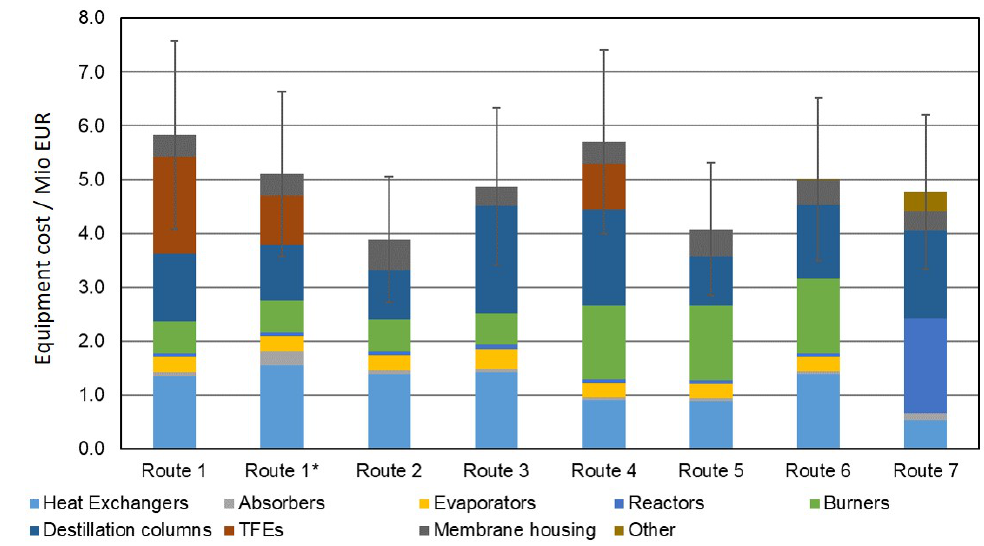
Figure 3. Equipment cost of all Routes for a plant size of 100 kt OME/a. The whiskers show the uncertainty in the total equipment cost for each route ( ± 30% [51]).